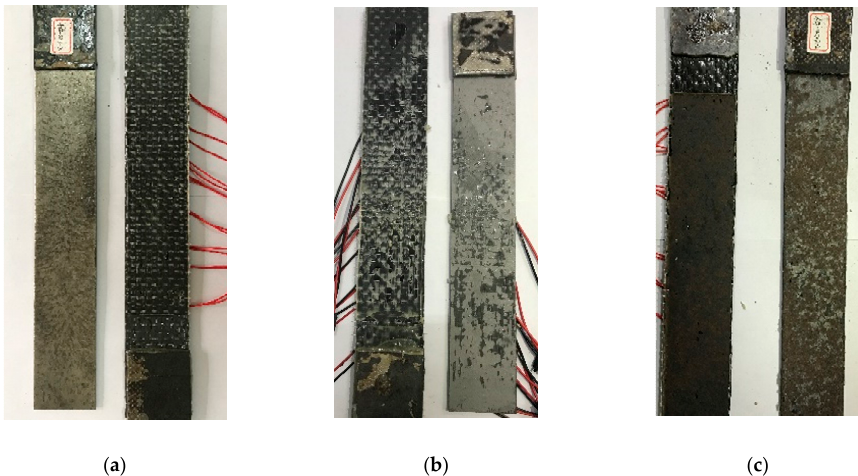
Figure 2. Failure mode of specimens: ( a ) Grinding wheel-polished specimen; ( b ) Sandblasted ( c ) No rust removal specimen; ( c ) No rust removal specimen.